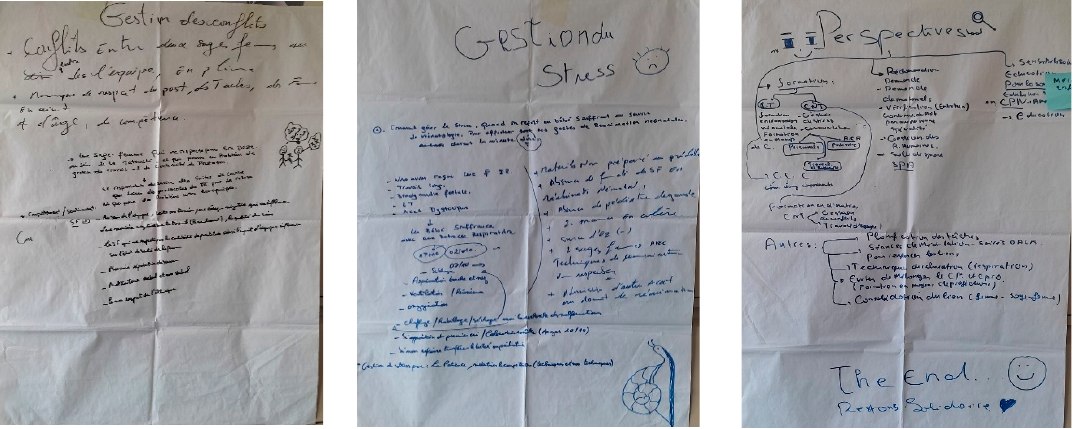
Figure 2. Scenario for the NTS of conflict- and stress-management, and the action plan for stress management.